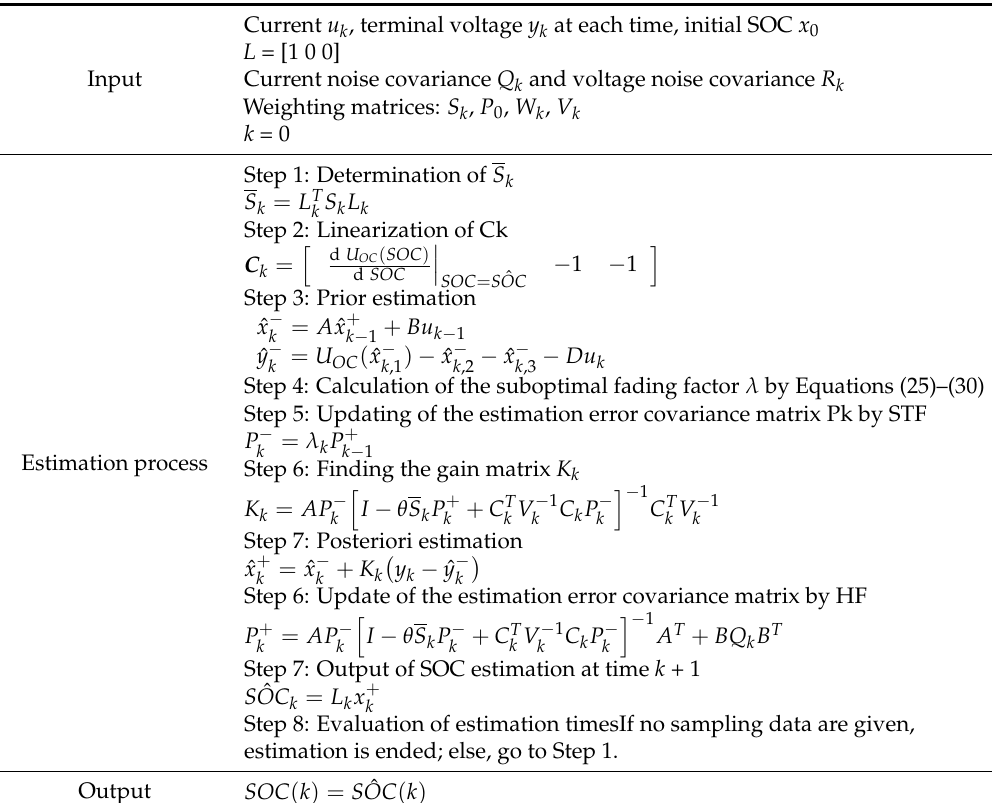
Table 4. Strong tracking H-infinity filter (STHF) algorithm for SOC